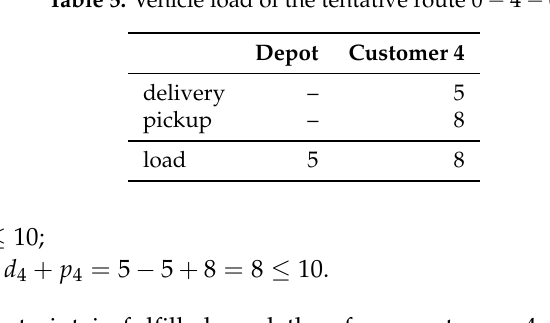
Table 5. Vehicle load of the tentative route 0 − 4 −